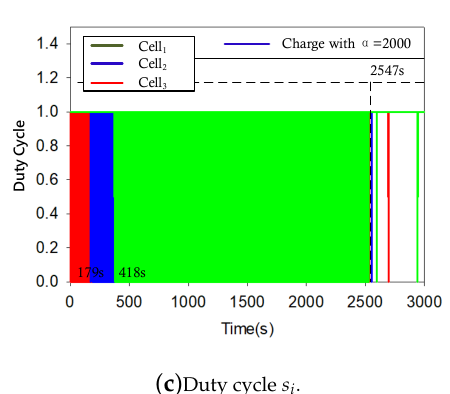
Figure 11. Results of the artificial potential field method with α =